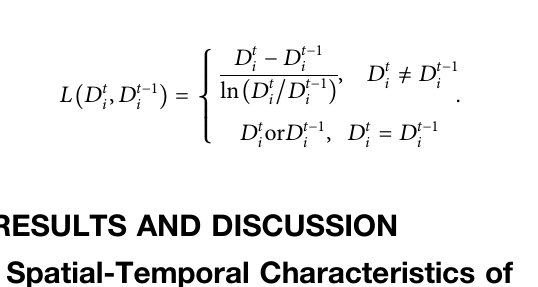
Frontiers in Environmental Science |